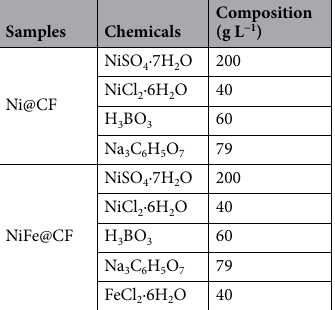
Table 1. Composition of different baths used for